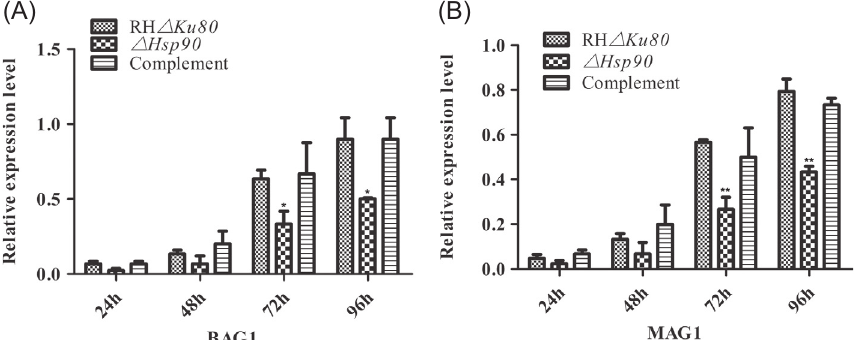
Figure 4. The relative expression level of BAG1 and MAG1. D Hsp90 , RH D ku80 and complemented parasites (10 5 ) were cultured in Vero cells for 24, 48, 72 and 96 h. The RNA was extracted by the Trizol dissociation method and detected by relative SYBR-green real-time PCR using actin transcripts as an internal control. * p < 0.05, ** p < 0.01. Data represent mean ± SD , n = 3